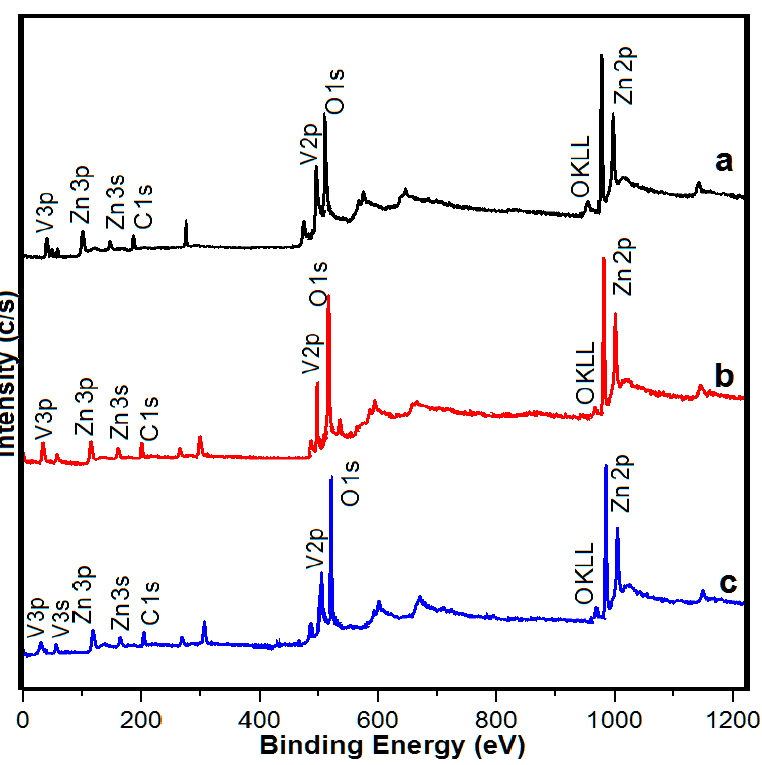
Figure 4. XPS spectra of ZnO/V 2 O 5 with seed layer deposition time of ( a ) 10 min, ( b ) 20 min, and ( c ) 30 min.